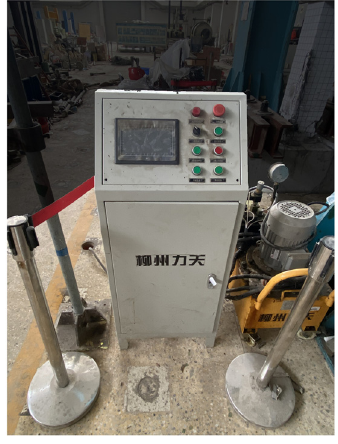
Figure 3: Hydraulic jack. Figure 4: Hydraulic control